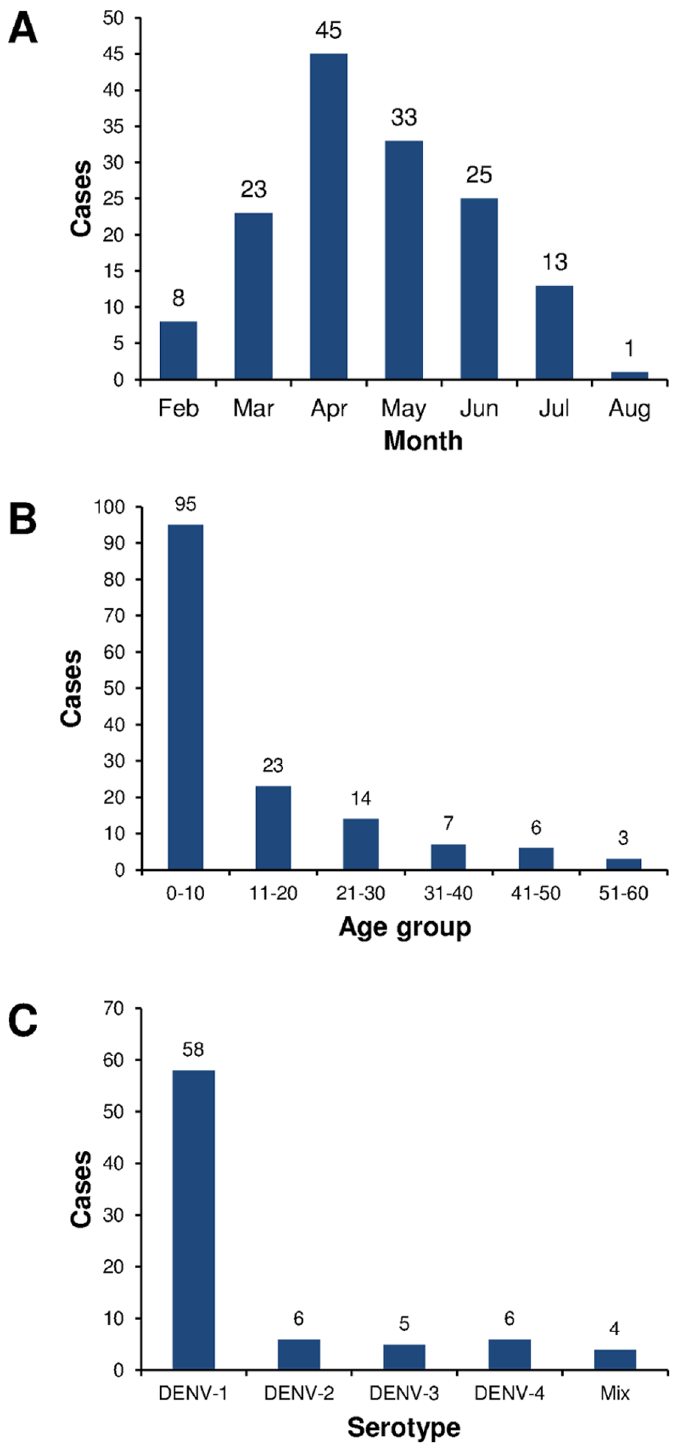
Fig 1. Dengue cases by monthly distribution (A), patients’ ages (B), and DENV serotype distribution (C) in Surabaya during 2012.